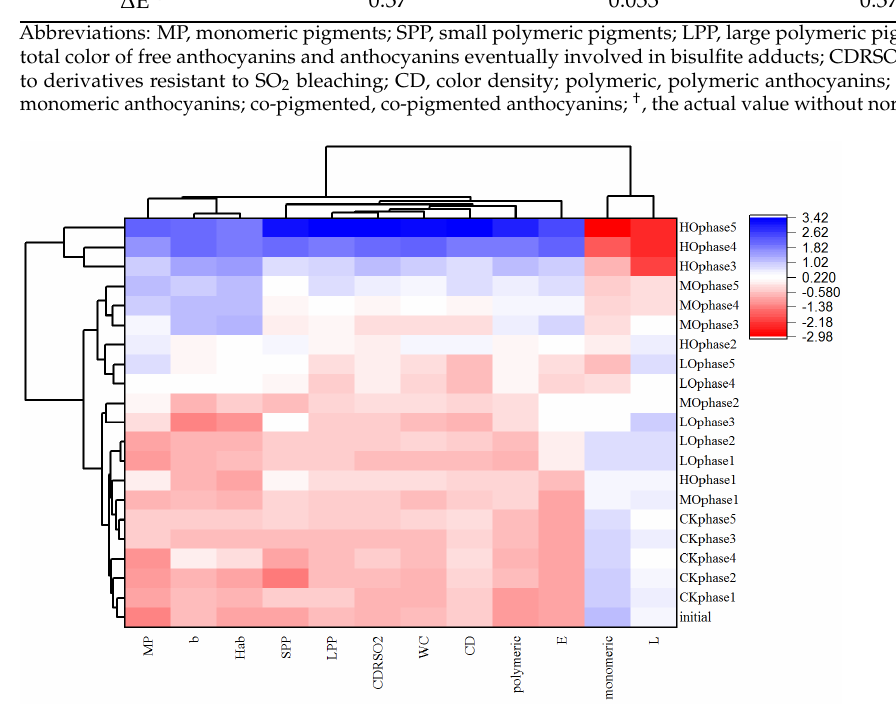
Figure 6. Total oxygen consumption during treatment. Abbreviations: initial, initial wine before ox- idation treatment; CK, anaerobic wine (0 mg O 2 /L per time); LO, low-level oxygenation wine (0.5– 0.9 mg O 2 /L per time); MO, medium-level oxygenation wine (1–1.9 mg O 2 /L per time); HO, high- level oxygenation wine (3–3.9 mg O 2 /L per time). Because of the successful classification of different wines according to the levels of oxygen consumption, a PLSR model explaining oxygen consumption at each oxygenation cycle interval was also built using the selected 12 parameters, which had the values of r above 0.85 shown in Table 3: oxygen consumption (mg/L) = − 32.97 + 5.67×MP + 7.61×SPP + 3.48×LPP + 7.54×WC + 0.21 × b − 0.24 × L + 0.184 × H ab + 0.22 × Δ E + 6.53 × CDRSO 2 + 3.98 × CD − 0.13 × Monomeric (%) + 0.13 × polymeric (%) where b was b*; L was L*; and Hab was H*ab. The regression model behaved fairly well in the range of oxygen consumption explored, giving good regression coefficients of 0.957